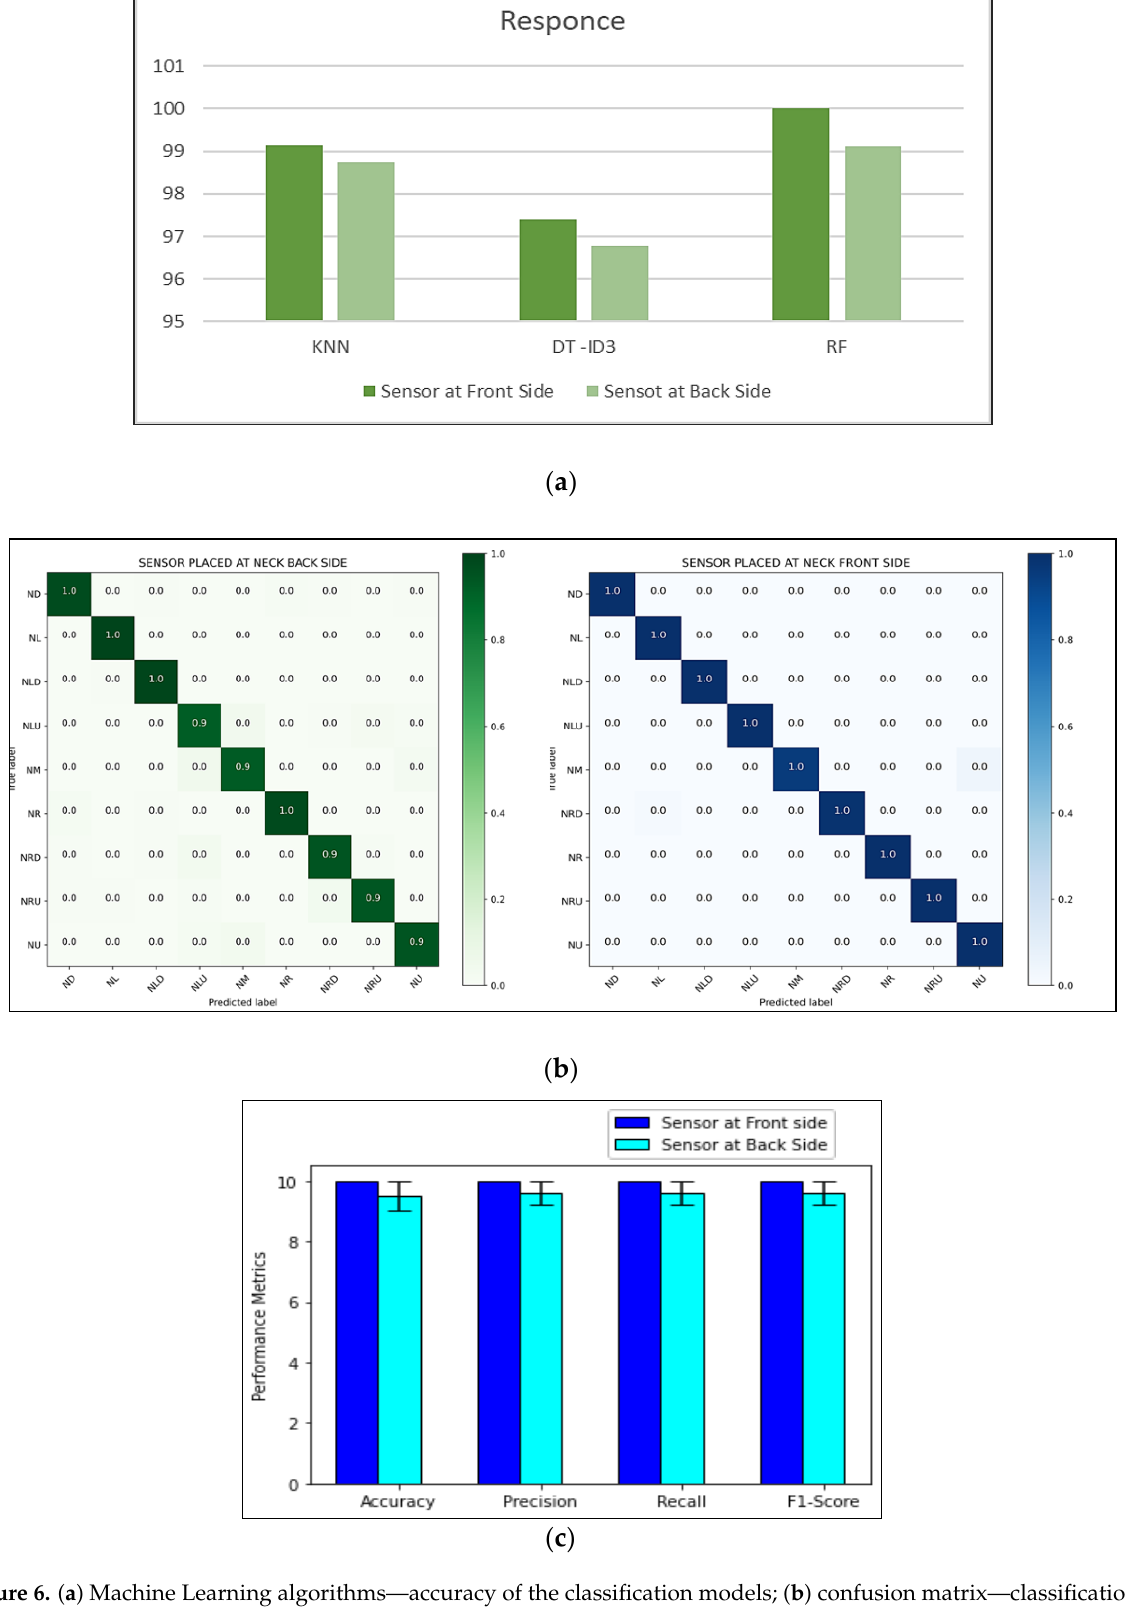
Figure 6. ( a ) Machine Learning algorithms — accuracy of the classification models; ( b ) confusion matrix — classification of neck posture based on sensor position; ( c ) performance metrics.